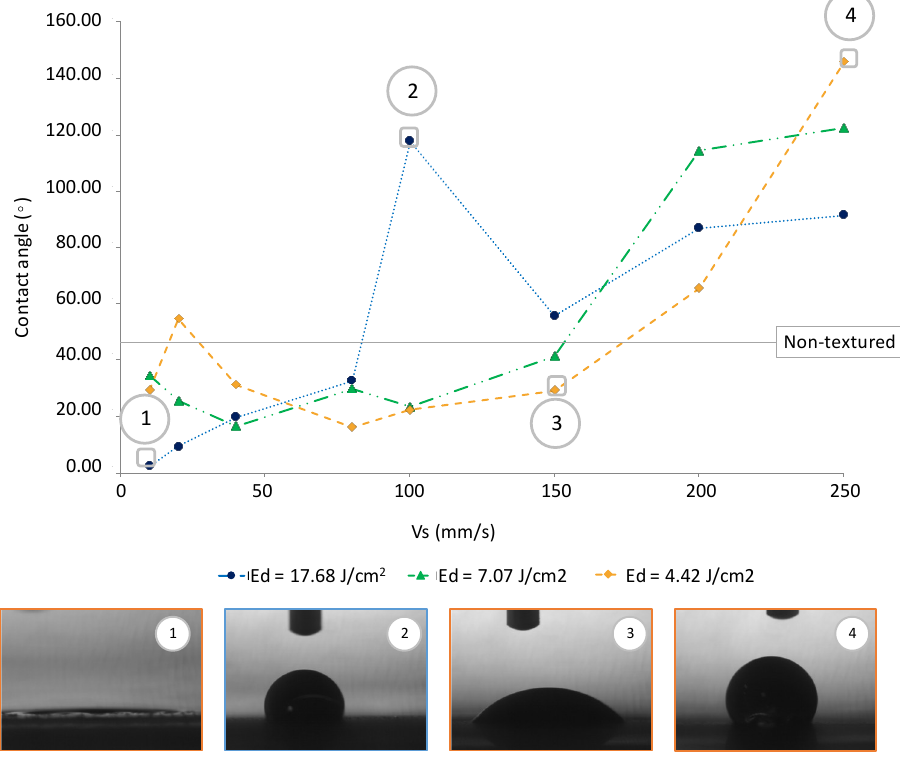
Figure 3. Contact angle as a function of V s .